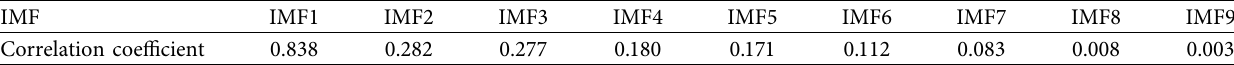
Table 1: Correlation coefficient between IMF and signal.